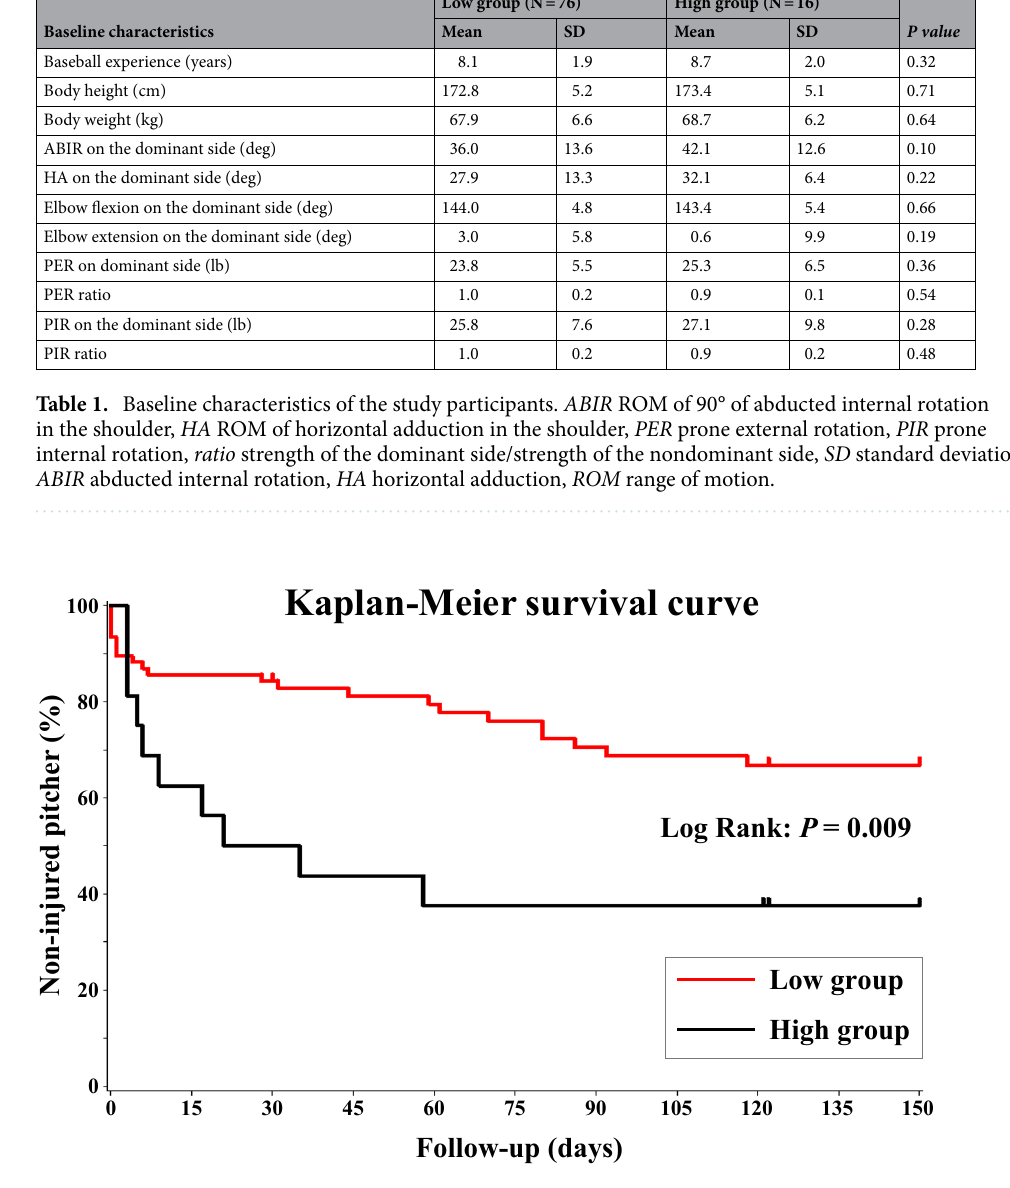
Figure 2. Kaplan–Meier survival curves. The median time to injury was 92 days and 28 days in the low group and high group, respectively. A log-rank test shows that the injury incidence is significantly lower in the low group than in the high group (P = 0.009).